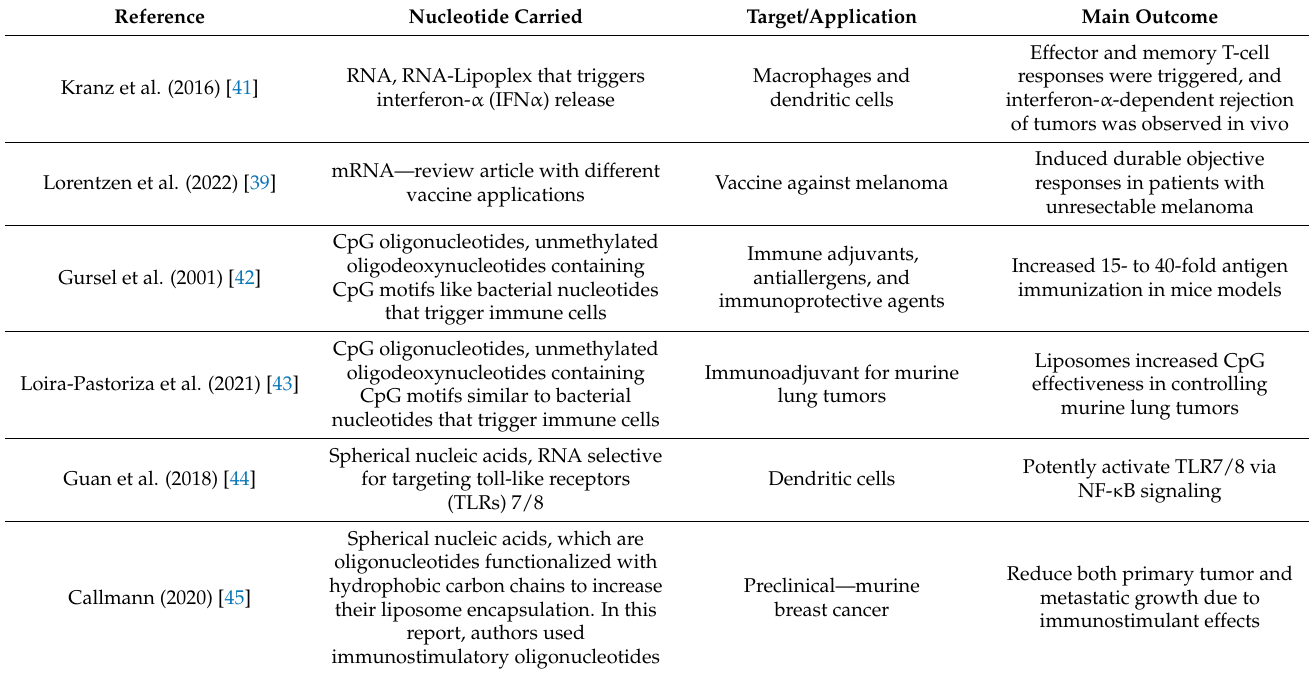
Table 2. Liposomes for the delivery of nucleic acids for immunostimulatory